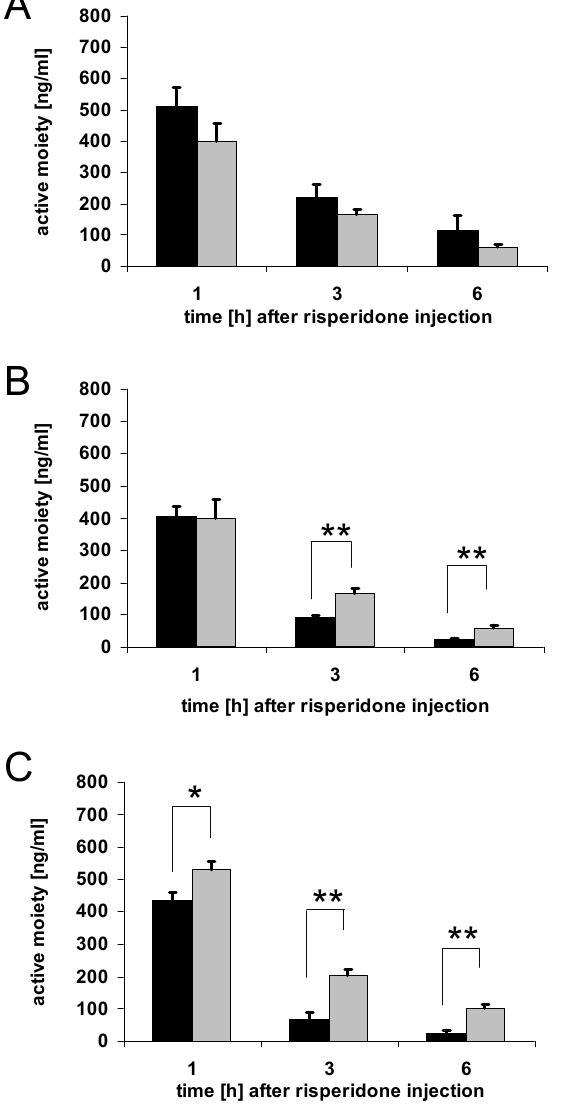
Figure 5. Serum concentrations of risperidone active moiety. Serum concentrations of risperidone active moiety after drug transporter induction with 10 mg/kg/d rifampicin (A), 50 mg/kg/d dexamethasone (B), or 25 mg/kg/d PCN (C) vs. controls for 4 days. Drug transporter induced mice = black bars, and controls = grey bars. Data presented are mean + /- S.E.M. (* p < 0.05; ** p <